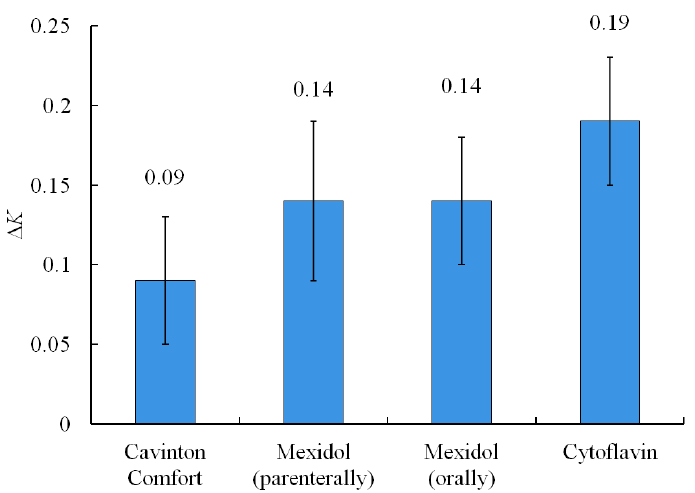
Figure 6. General change of total activity of antioxidants in the blood serum before and after treatment.